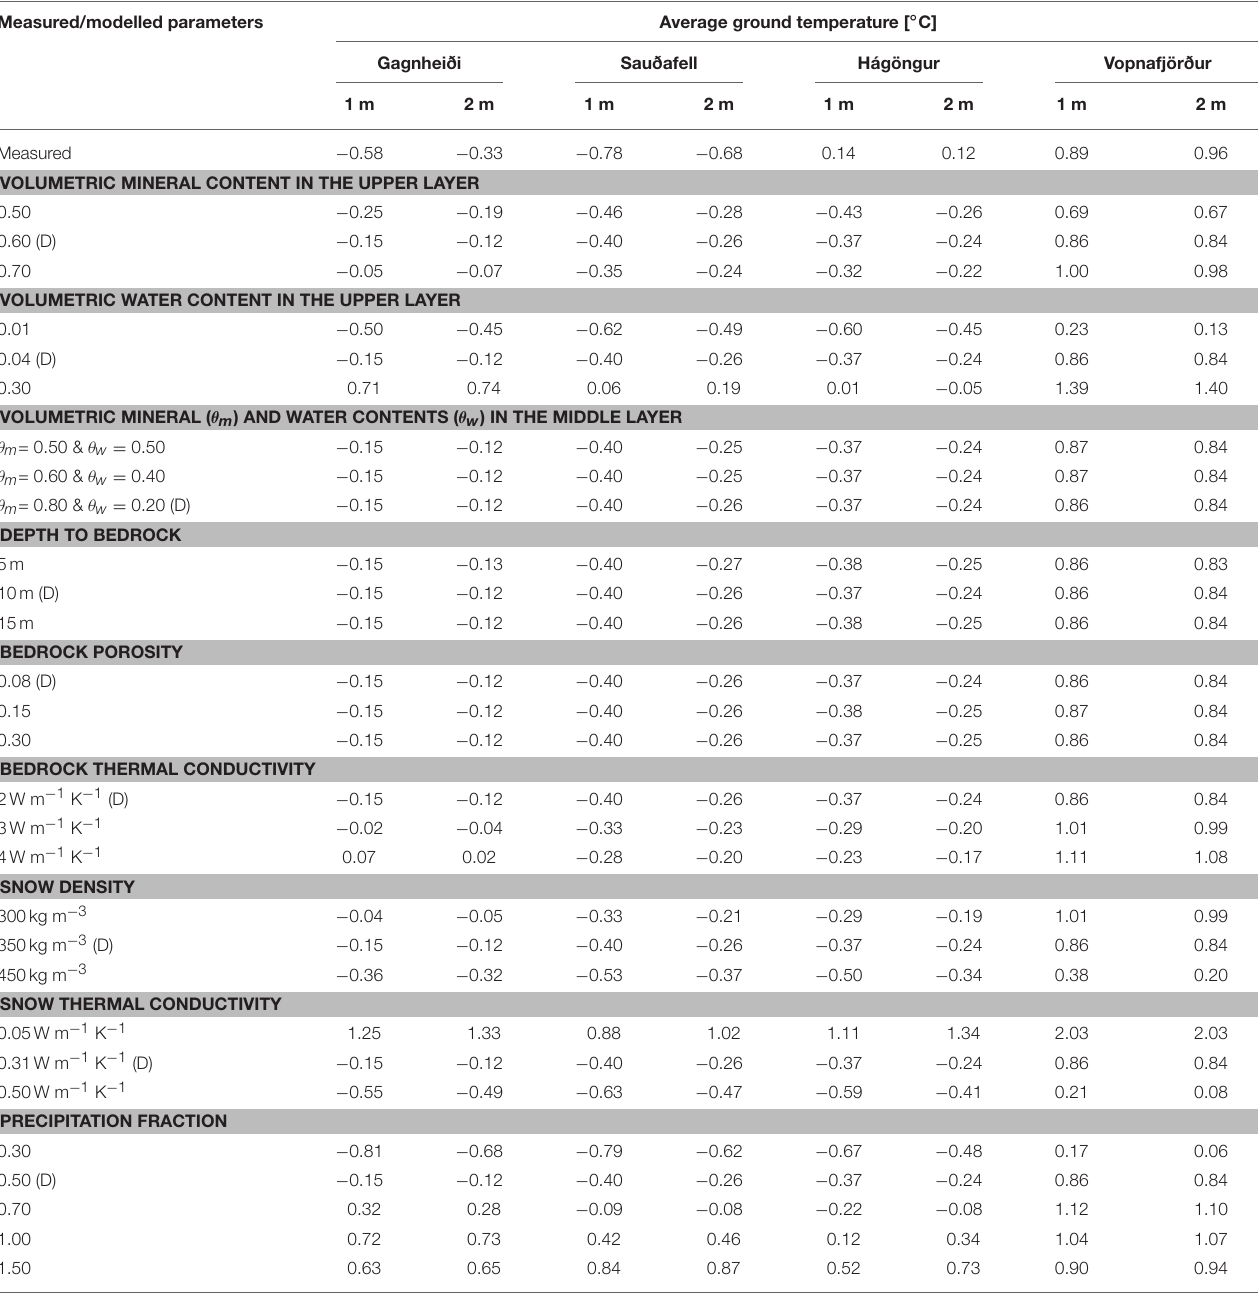
TABLE 3 | Sensitivity of the modelled mean ground temperature at depths of 1 and 2m to uncertainties in the chosen subsurface and snow parameters in the period 1.09.2004–31.08.2006. Measured/modelled